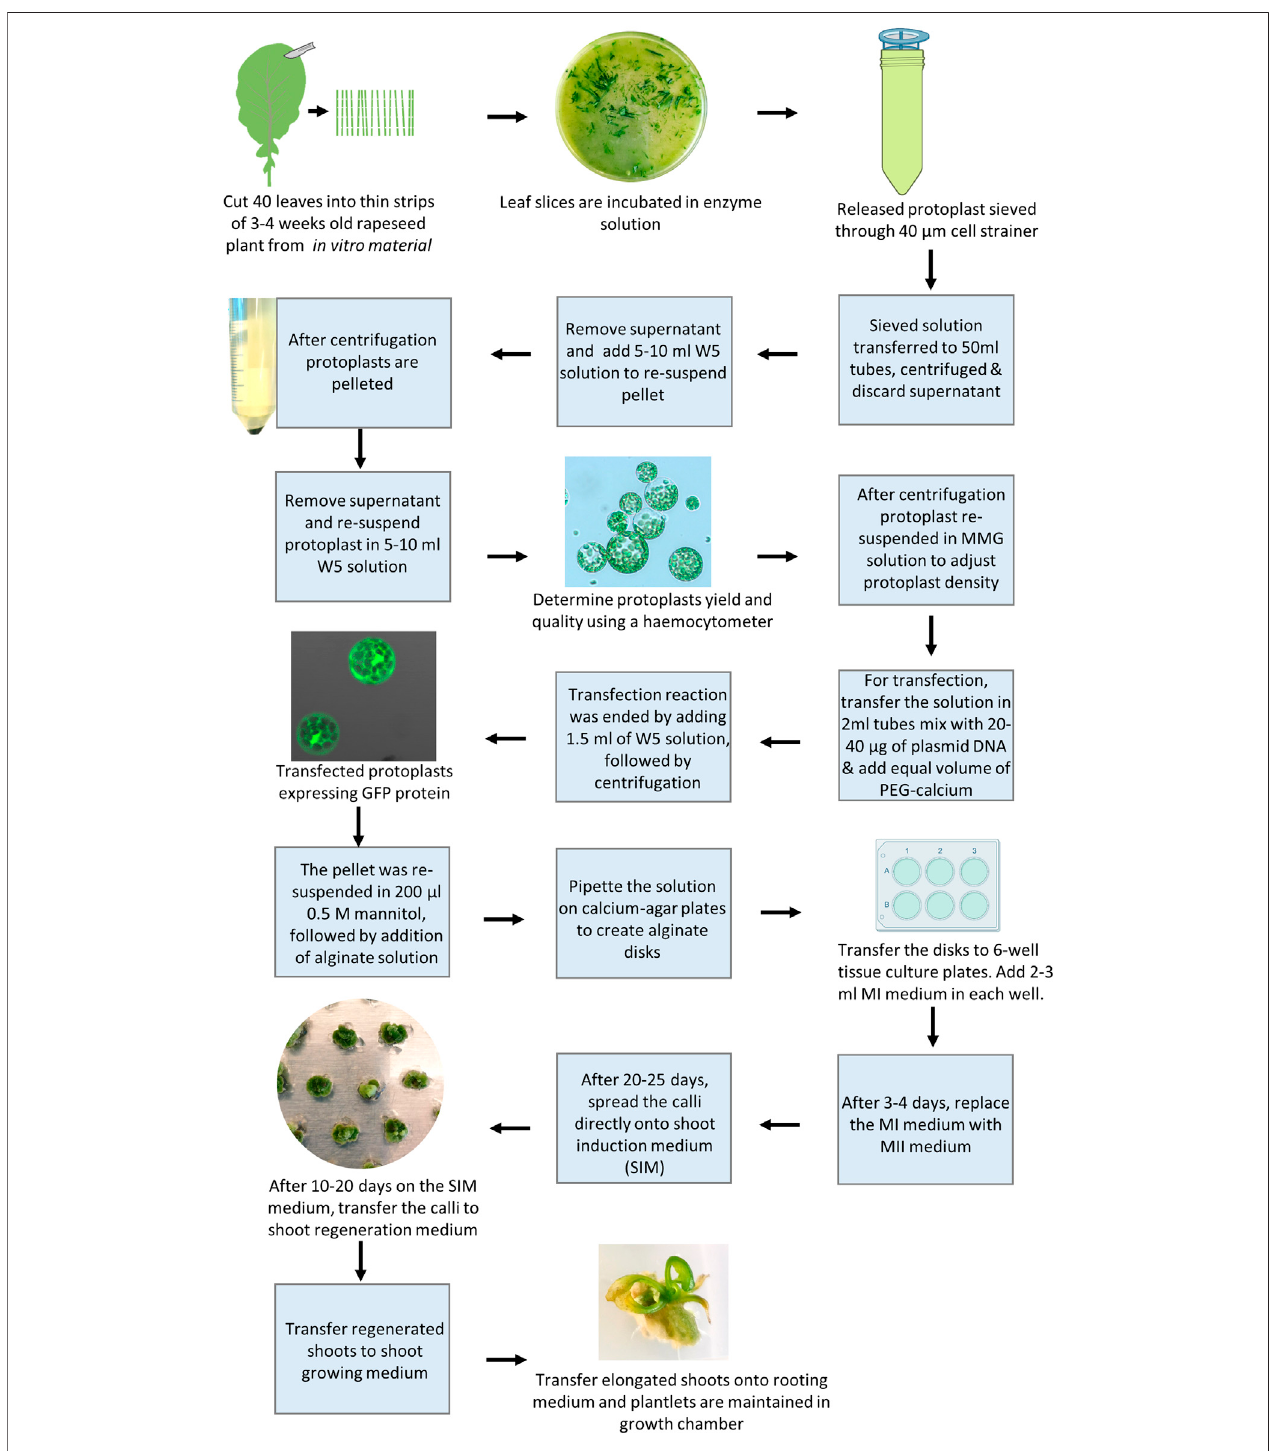
FIGURE 2 | Overview of protoplast regeneration and transfection of rapeseed ( Brassica napus )